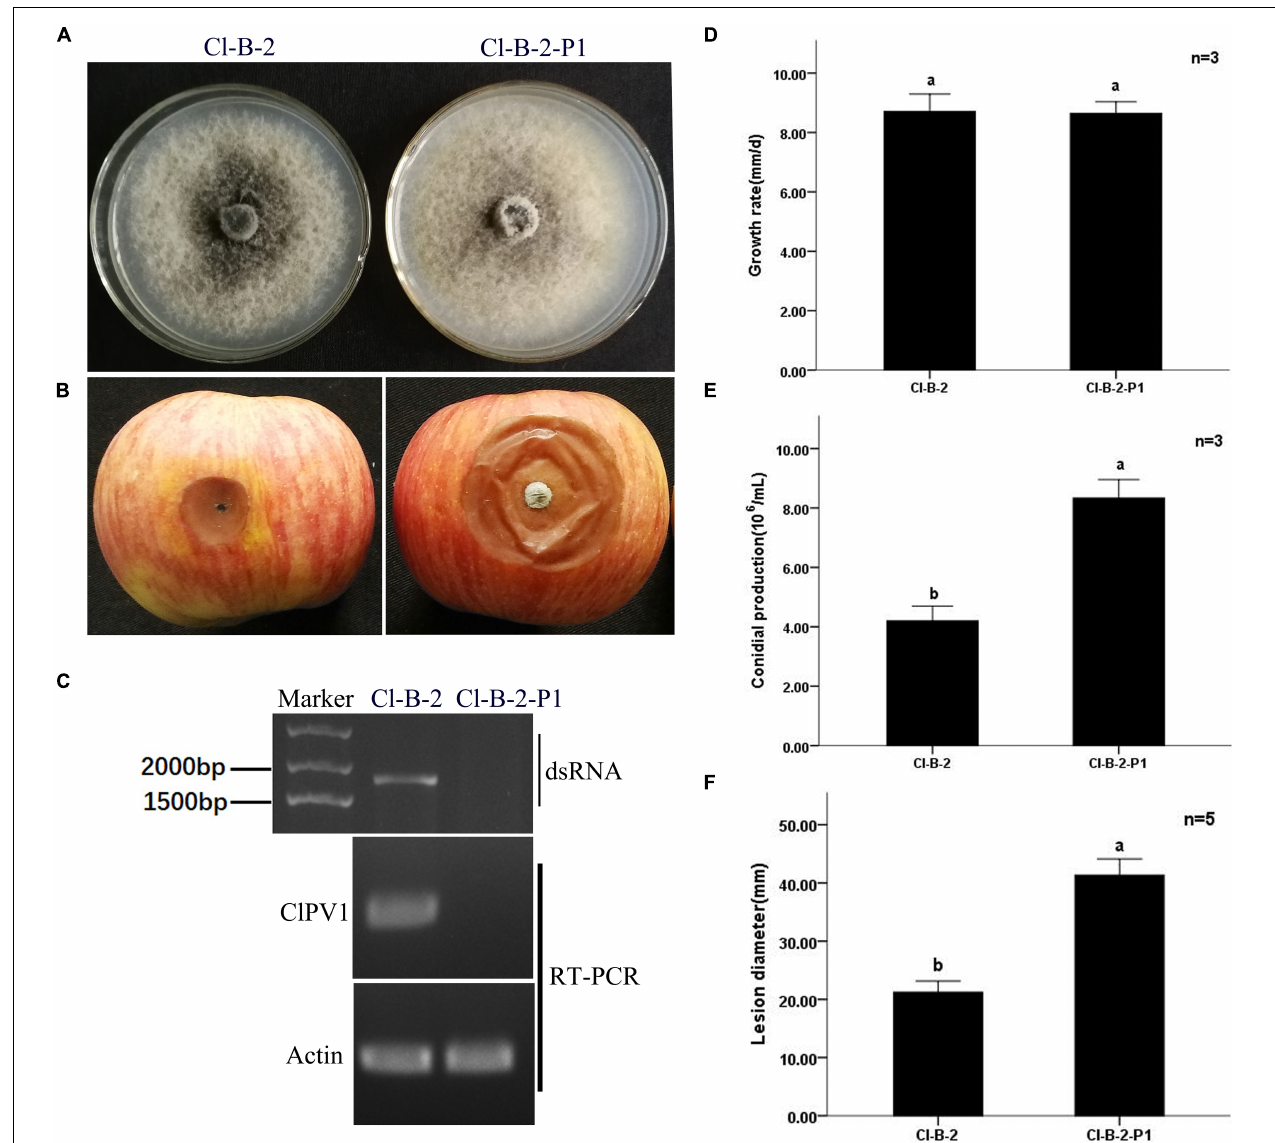
FIGURE 6 | Virus curing of ClPV1 from C. liriopes strain Cl-B-2. (A) Colony morphology of C. liriopes strain Cl-B-2 and a virus free derivative of Cl-B-2-P1. Fungal strains were grown on PDA at 27 ◦ C for 7 days. (B) Pathogenicity analysis of the Cl-B-2 and Cl-B-2-P1 strains. The symptoms were observed 14 days post inoculation. (C) Detection of ClPV1 in strains Cl-B-2 and Cl-B-2-P1 using dsRNA extraction and RT-PCR methods, with the actin gene of C. liriopes served as an internal control. (D) Comparison of the average radial mycelial growth rates between the two fungal strains after being cultured at 27 ◦ C on PDA for 7